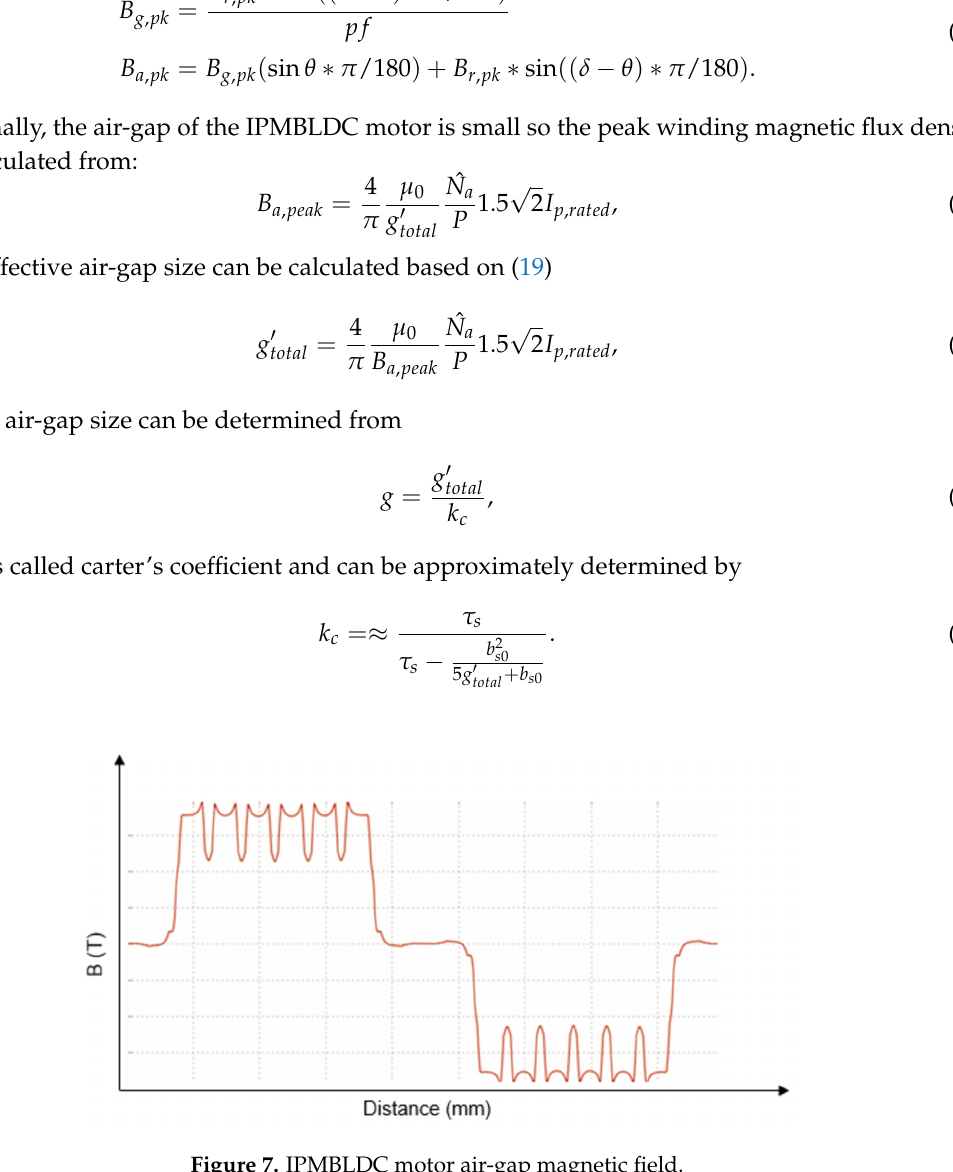
Figure 7. IPMBLDC motor air-gap magnetic field.